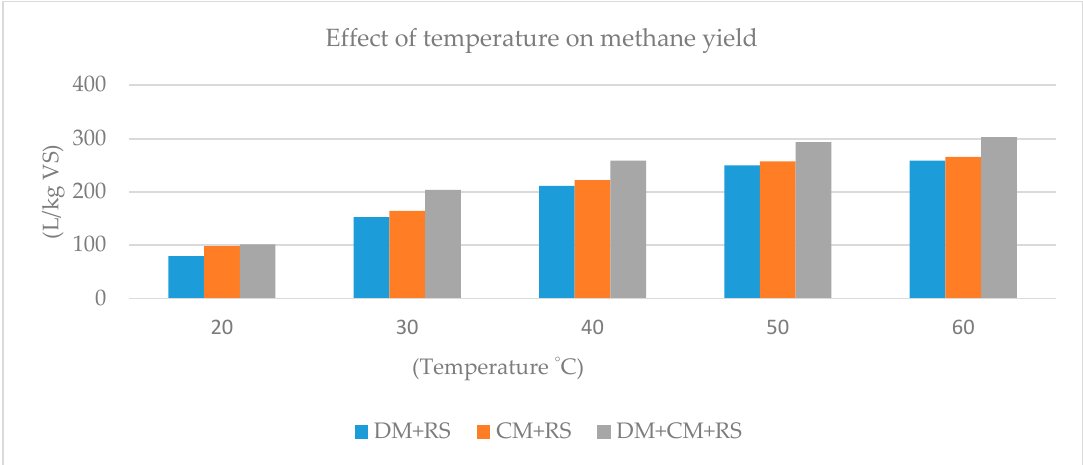
Figure 5. Effect of temperature on methane yield. Values are presented as the mean of three replicates (n = 3). DM, Dairy manure; CM, Chicken manure; RS, Rice straw [26].